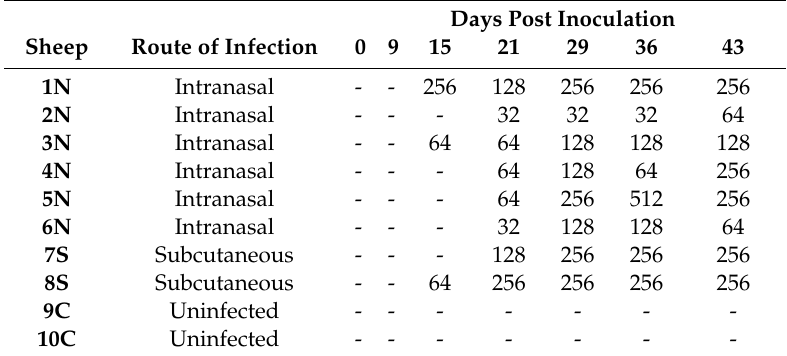
A dash indicates that neutralising anti-Bungowannah virus antibodies were not detected.